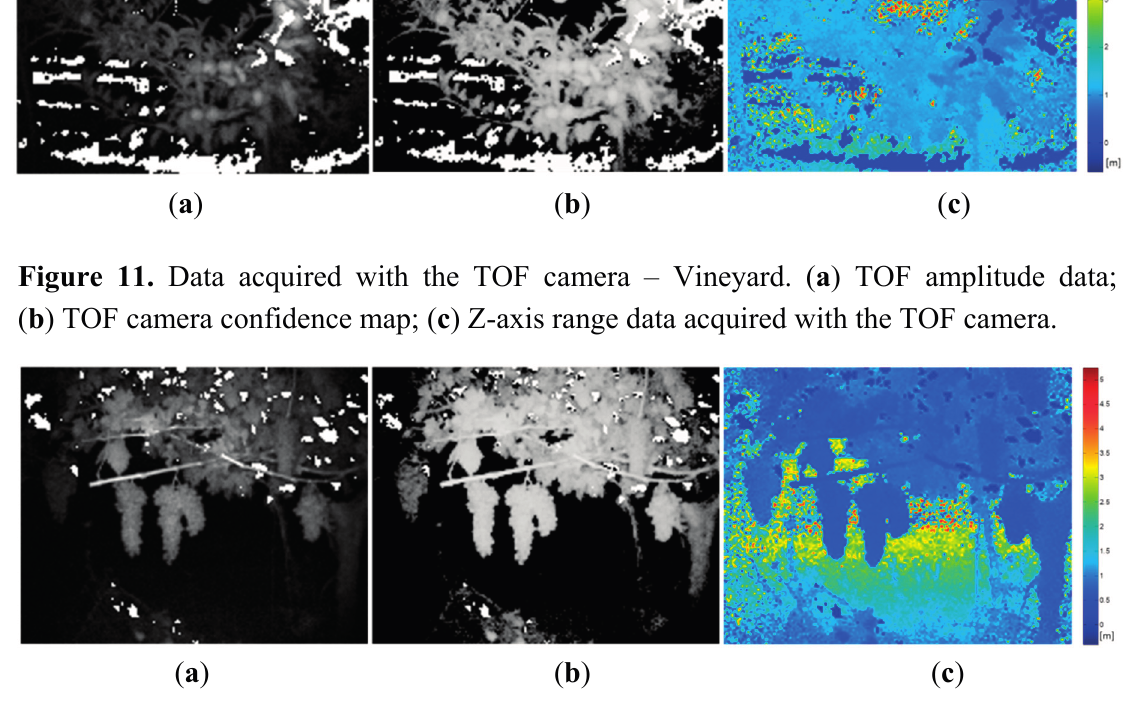
Figure 12. Registered data – Apple crop. ( a ) Registered multispectral map; ( b ) TOF registered amplitude data; ( c ) TOF registered Z-axis range